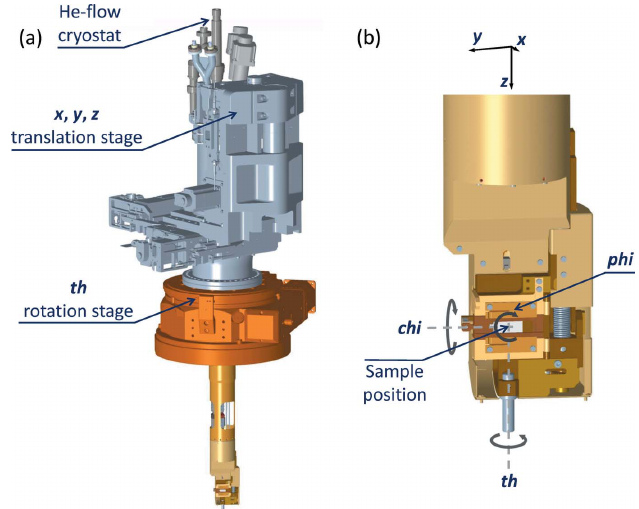
Figure 13 The I21 sample manipulator. In panel ( a ) the whole manipulator is shown, with the key out-of-vacuum components labelled. Panel ( b ) shows the sample holder of the manipulator, with all six degrees-of-freedom